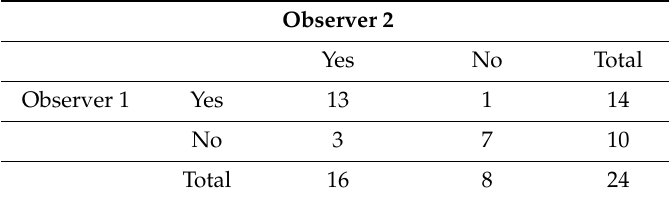
Table 2. Contingency table of the two rates regarding the T2–FLAIR mismatch sign. Observer 2 Yes No Total